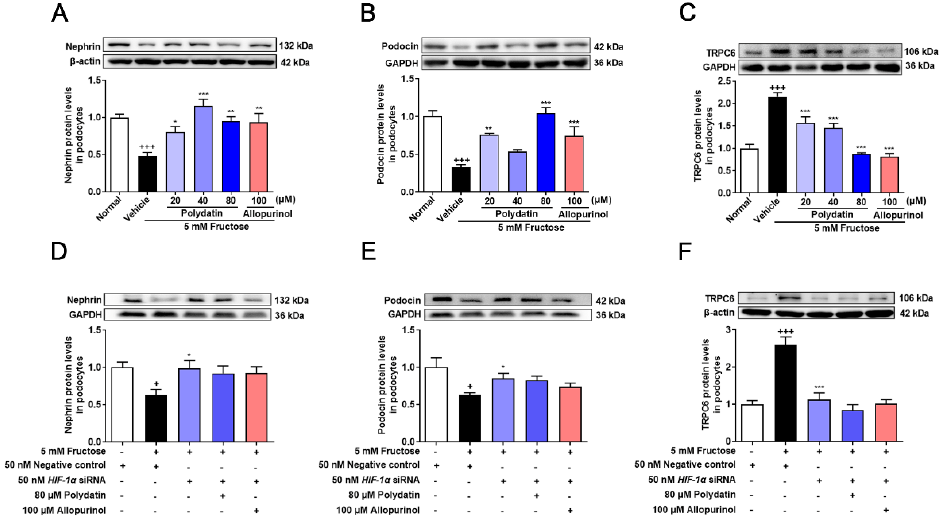
Figure 4. Polydatin prevents high fructose-induced podocyte structural damage. ( A – C ) Relative protein levels of nephrin (72 h) ( n = 6) ( A ), podocin (72 h) ( n = 5–7) ( B ), and TRPC6 (72 h) ( n = 6) ( C ) were detected in podocytes cultured with or without fructose (5 mM) in the presence or absence of polydatin (20, 40, and 80 µ M) or allopurinol (100 µ M) by Western blot and quantified by Image J. ( D – F ) Relative protein levels of nephrin (48 h) ( n = 4–5) ( D ), podocin (48 h) ( n = 5) ( E ), and TRPC6 (48 h) ( n = 5–8) ( F ) were detected in podocytes transfected with HIF-1 α siRNA and then incubated with or without fructose (5 mM), polydatin (80 µ M) and allopurinol (100 µ M) by Western blot and quantified by Image J. Data are expressed as the mean ± S.E.M. + p < 0.05, +++ p < 0.001 compared with normal control group or negative control group, * p < 0.05, ** p < 0.01, *** p < 0.001 compared with fructose vehicle group.